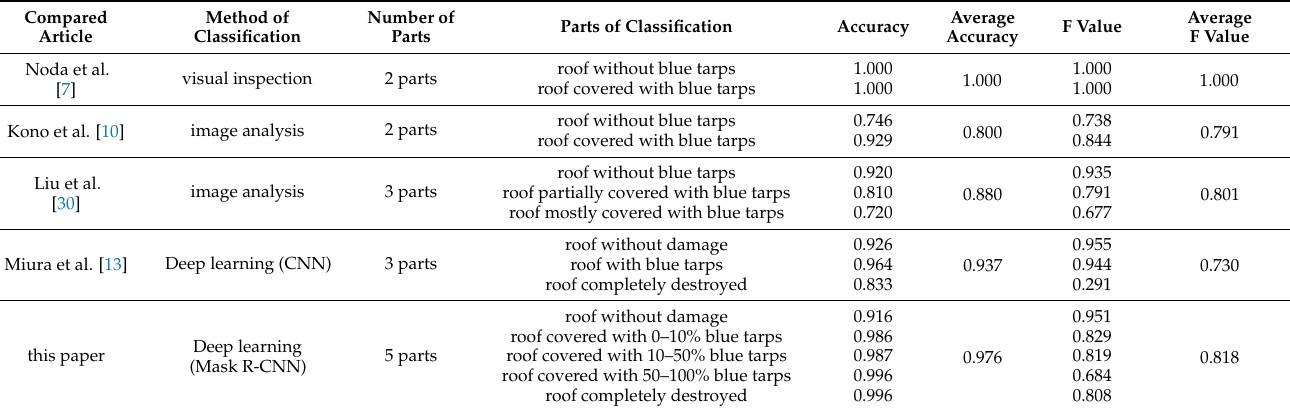
Table 7. Comparison with other classification methods.